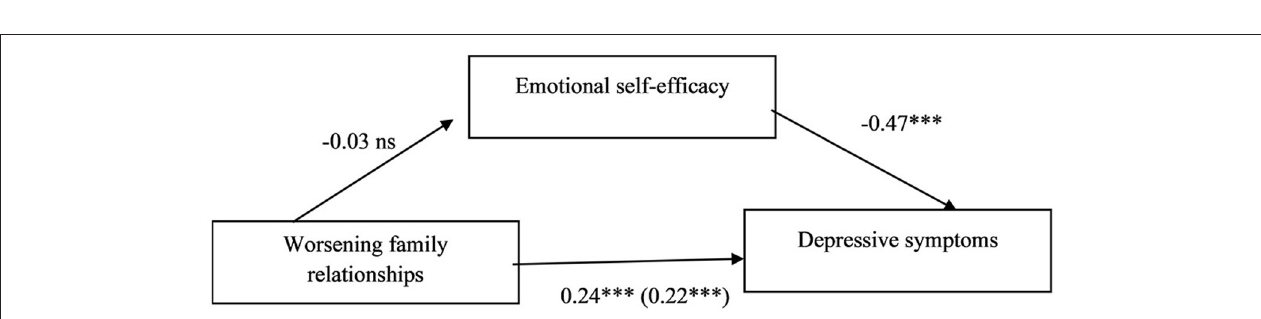
FIGURE 1 | Standardized regression coefficients (beta) for the relation between COVID-19 contagion concern and depressive symptoms as mediated by emotional self-efficacy. * p < 0.05; ** p < 0.01; and *** p < 0.001. In parenthesis the standardized regression coefficient between the independent variable and the dependent variable controlling for the mediator Gender beta = − 0.21***. R 2 = 0.26; F (3, 292) = 34.57, p < 0.001.